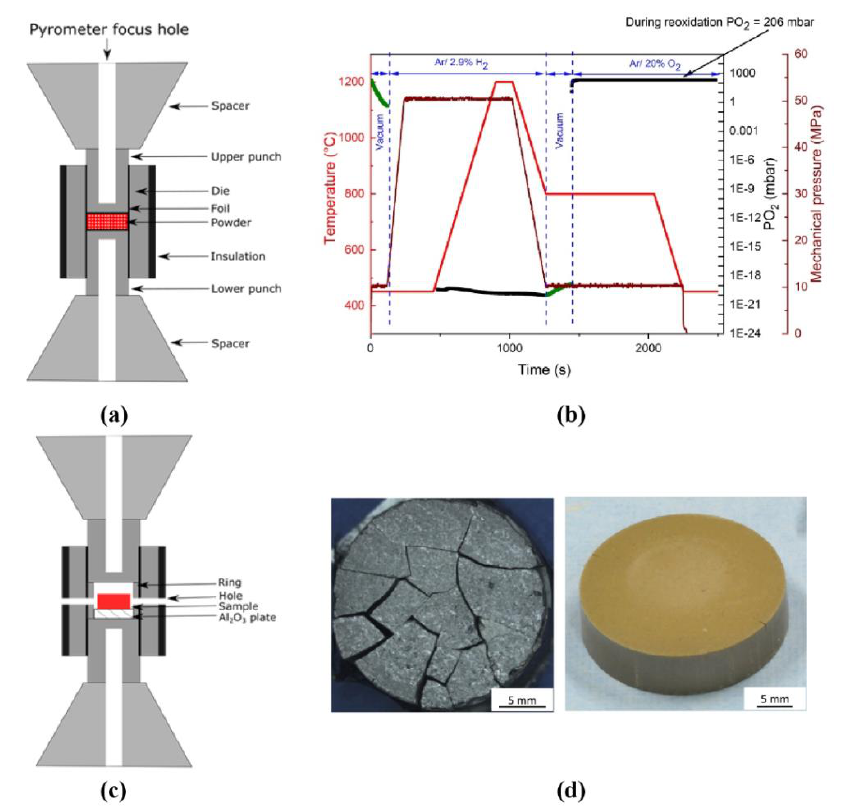
Figure 2. ( a ) Setup for pressure-assisted FAST / SPS; ( b ) redox cycle; ( c ) setup for pressureless FAST / SPS; ( d ) fractured sample after pressure-assisted sintering (left) and sample after pressureless redox sintering (right).